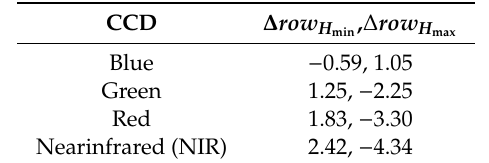
Table 9. Estimated parameters of the row coordinate di ff erences due to terrain elevation variations.